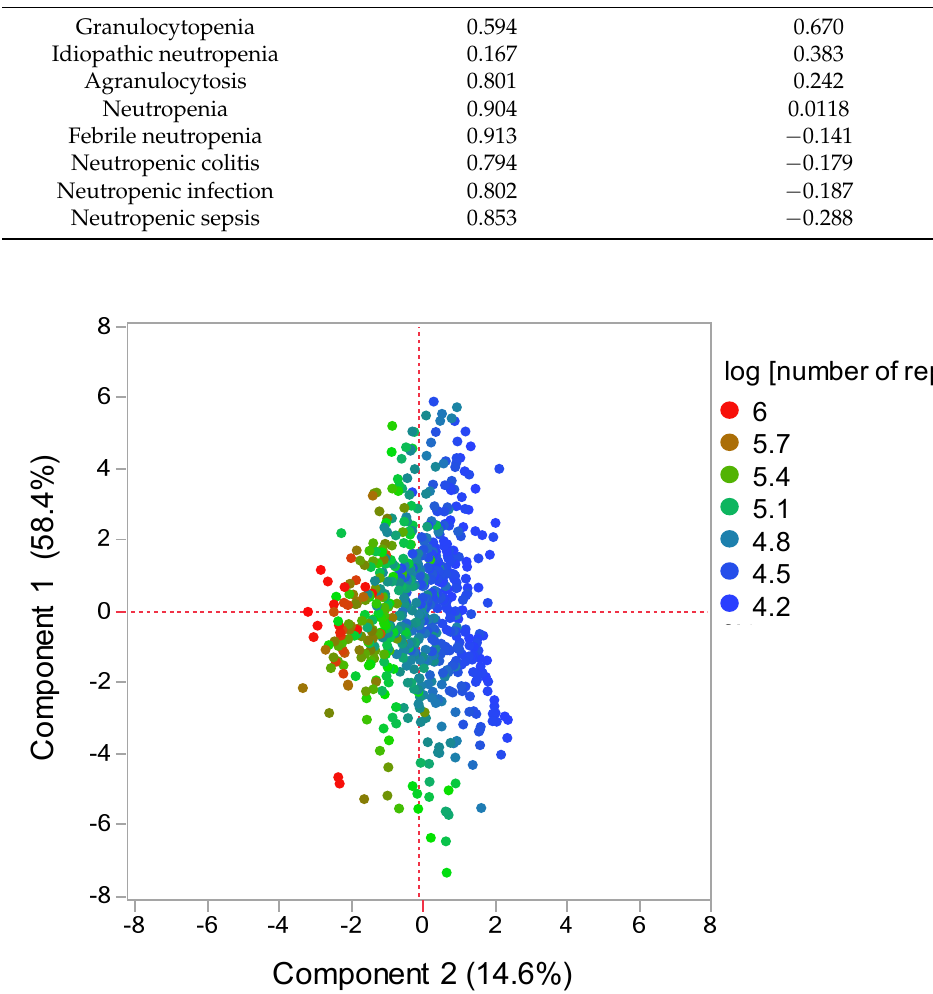
Figure 4. Score plot related with components 1 and 2. The score plot shows the relationships between the drugs and principal components. Each plot indicates a drug. Plot colors indicate log (number of reports).